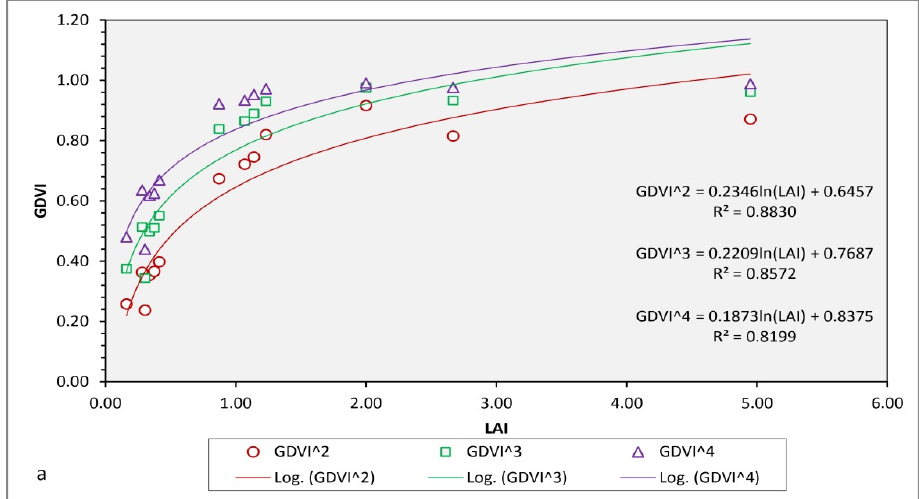
Figure 5. Logarithmic relationships between vegetation indices and LAI (image pair dated 1 May 2007. ( a ) GDVI vs. LAI, ( b ) VIs with positive range vs . LAI, and ( c ) VIs with negative range vs .